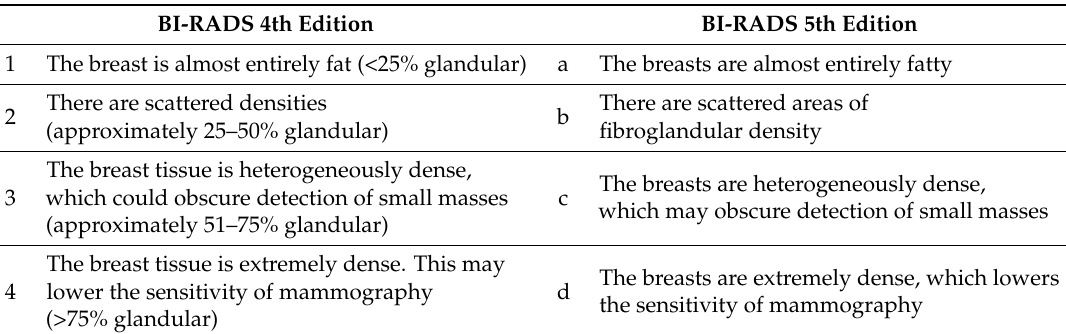
Table 1. BI-RADS 4th and 5th edition category